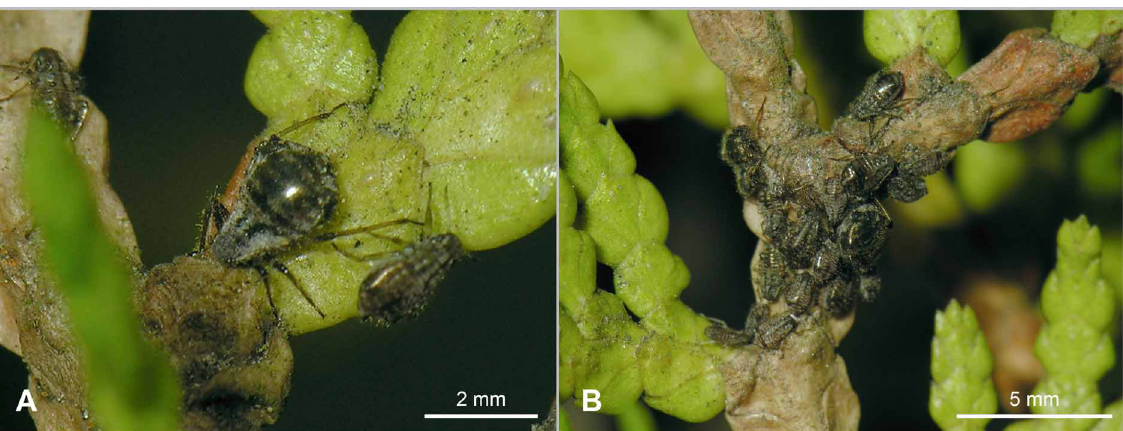
Fig. 117. Cinara (Cupressobium) cupressi (Buckton, 1881). Small colony on last year’s growth of Thuja occidentalis , attended by Lasius niger (Linnaeus, 1758).